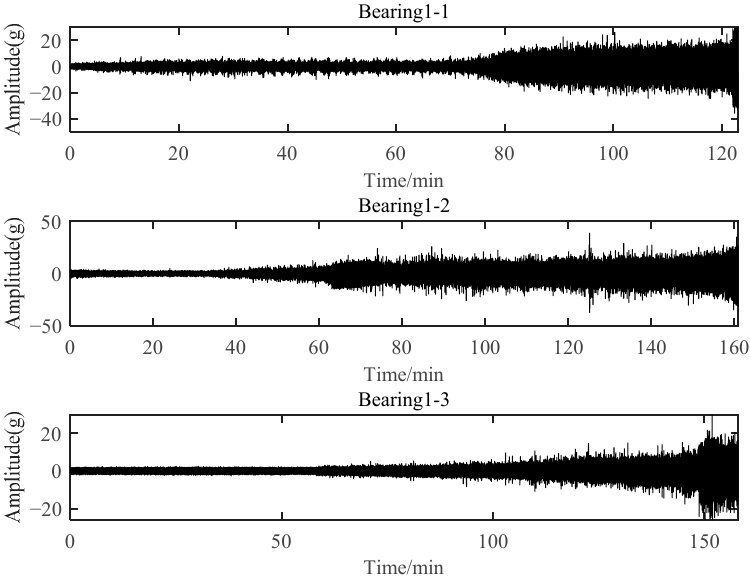
Figure 21. Horizontal vibration signal of three bearings.